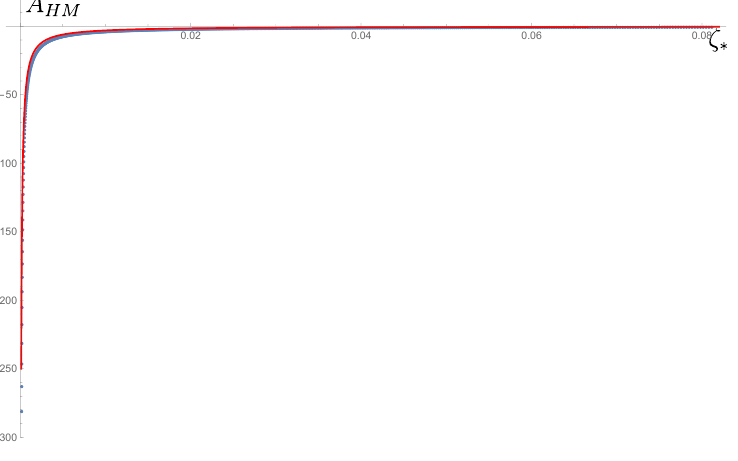
) from theory, namely − 0 . 030 /ζ . Close to the horizon, ∗ ∗ the finite temperature kicks in ∗